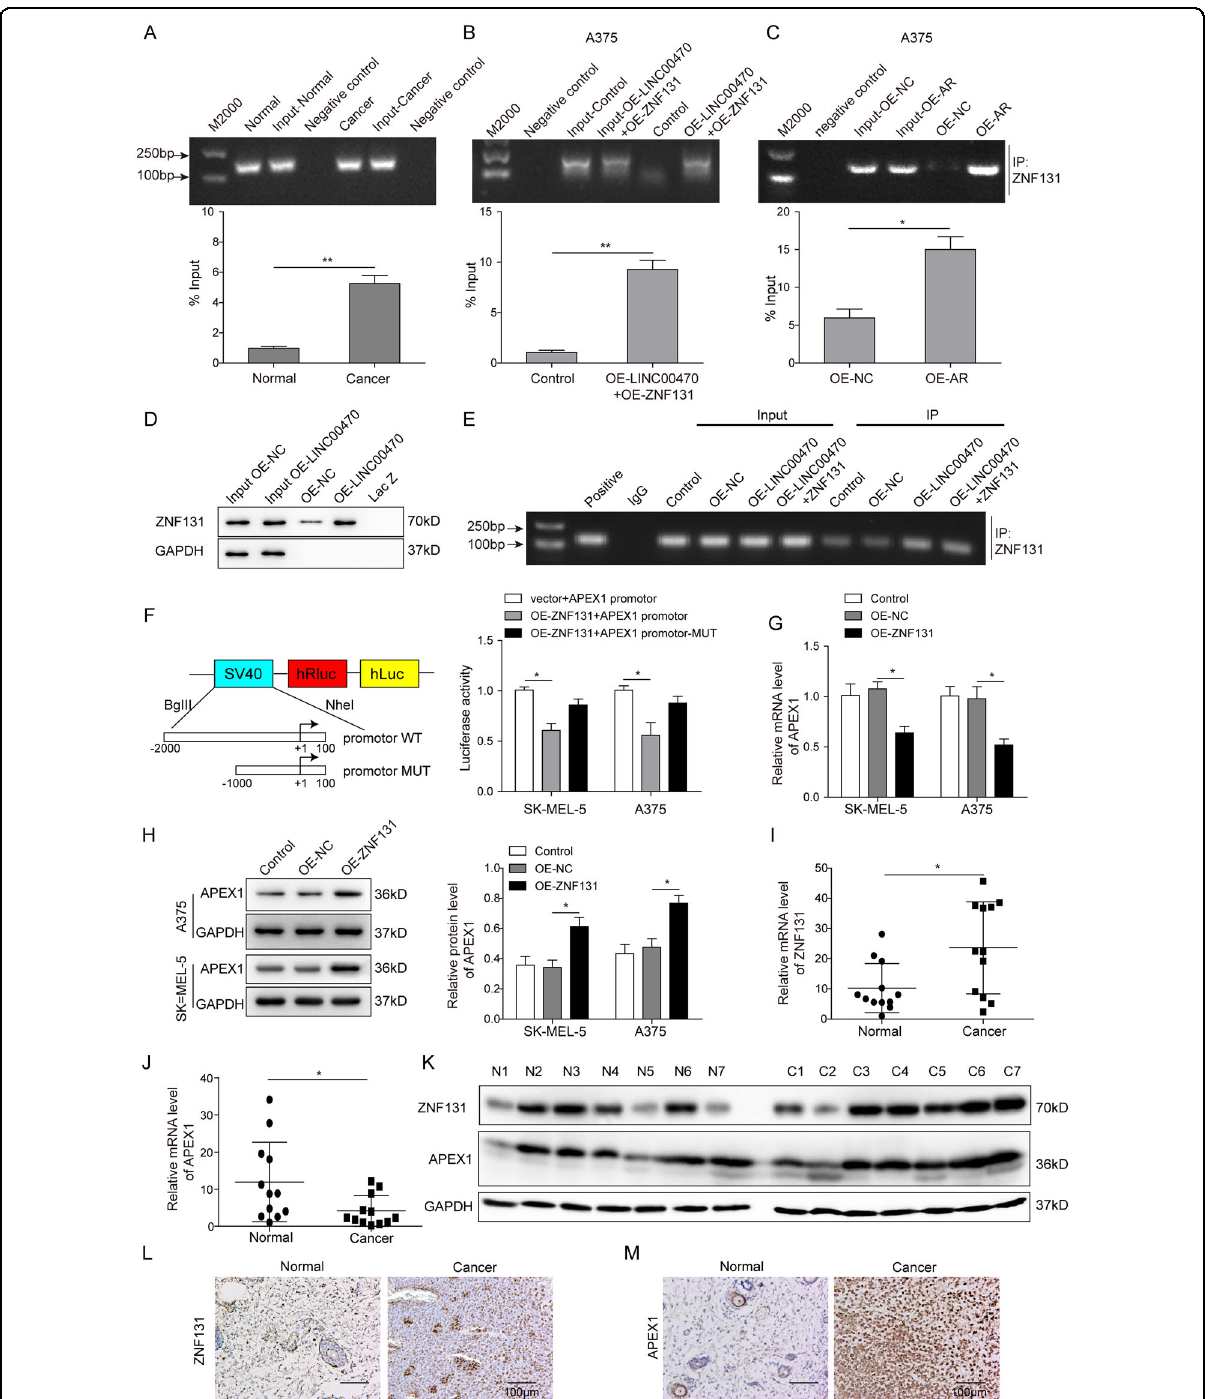
Fig. 5 LINC00470 activated ZNF131 to inhibit the transcription of APEX1. A The interaction of LINC00470 and ZNF131 was detected by RIP assay in normal and melanoma tissues. B , C RIP assay showed the enrichment of LINC00470 and ZNF131 in melanoma cells or the AR-overexpressed melanoma cells. D RNA pull-down and western blot analysis after the cells were transfected with OE-NC and OE-LINC004705. E CHIP assay analysis after the cells were transfected with control, OE-NC, OE-LINC00470, and OE-LINC00470 with OE-ZNF131. F Dual-luciferase assay was used to investigate the interaction between ZNF131 and APEX1. G , H qRT-PCR and WB assay showed the expression level of APEX1 in ZNF131-overexpressed melanoma cells. qRT-PCR analysis of ZNF131 ( I ) and APEX1 ( J ) in melanoma tissues and normal tissues. K The protein expression of APEX1 and ZNF131 in melanoma and normal tissues using western blot. IHC assay was conducted to evaluate the levels of ZNF131 ( L ) and APEX1 ( M ) in melanoma and normal tissues. The mean ± SD in the graph shows the relative levels from three replicates. *p < 0.05, ** p <